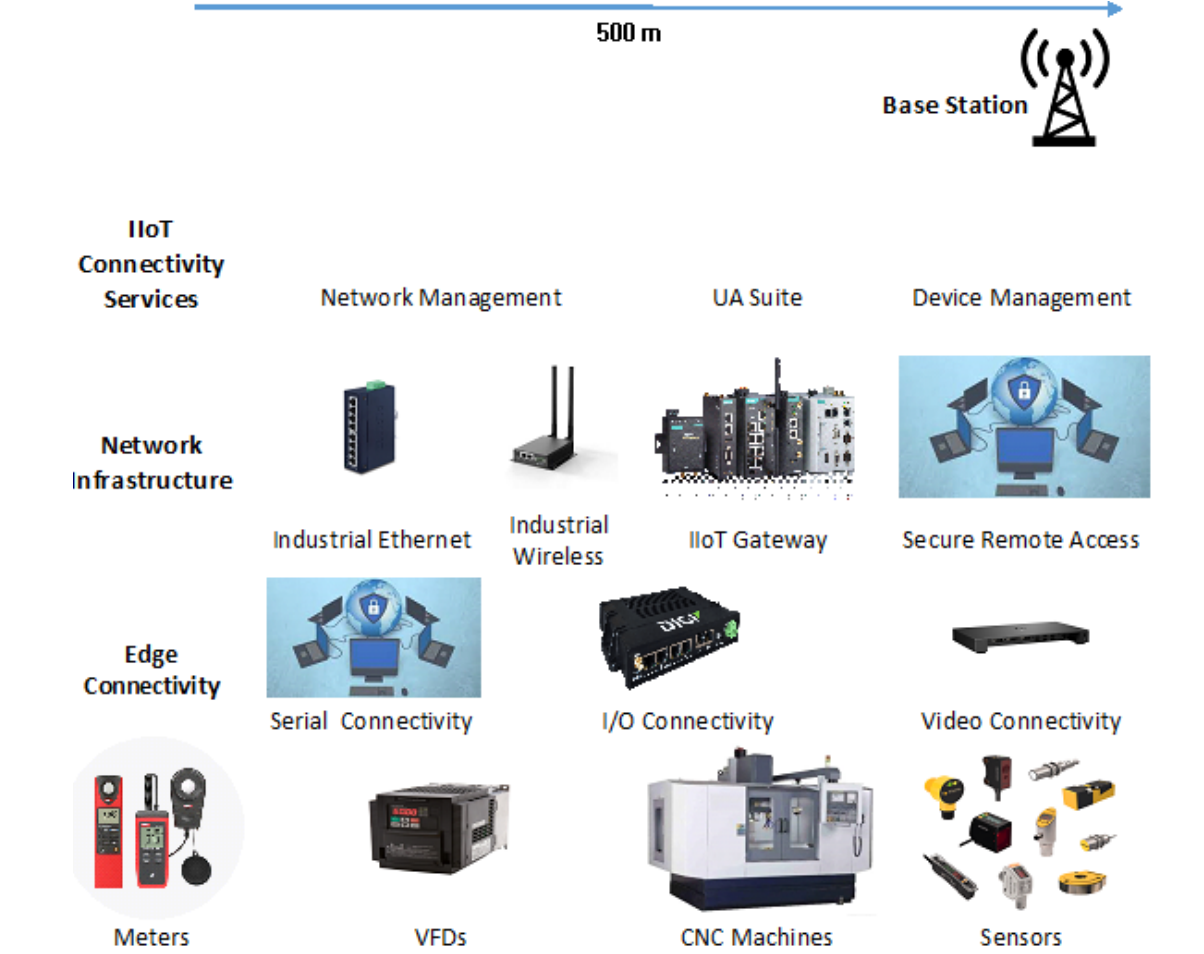
Figure 2. Wireless factory automation of IIoT devices.